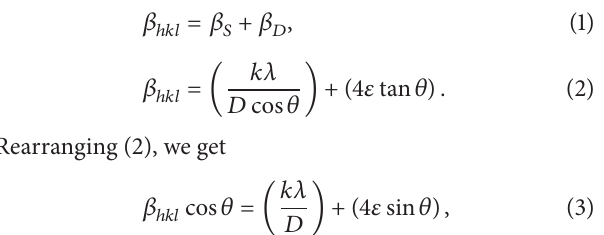
films were subsequently annealed for 30 min at 923 K in